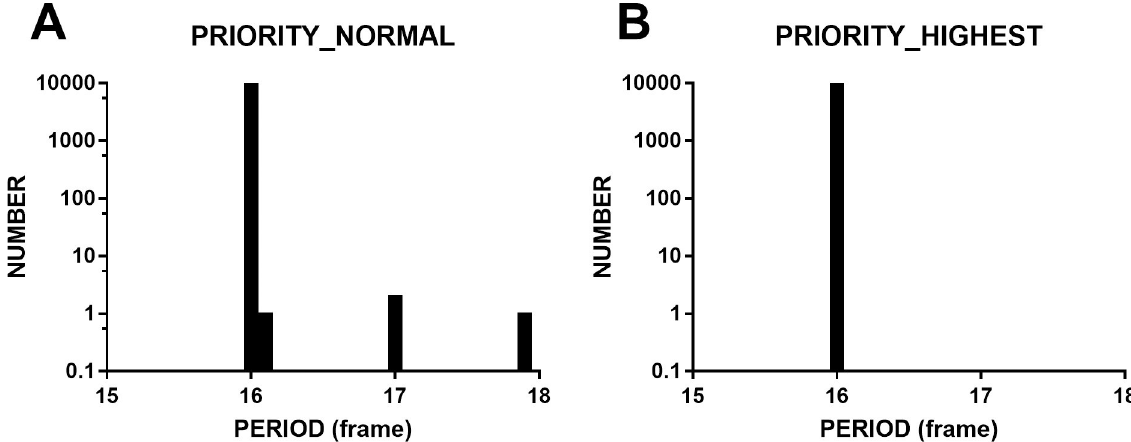
Fig 2. A: shows running at normal priority, and B: shows running at real-time priority. The periods at normal priority were distributed between 15.9 frames and 18.0 frames, and longer periods occurred rarely (mean = 16.0 frames, SD = 0.02 frames, range = 1.9 frames, FLR = 0.04%). The periods at real-time priority were 16.0 frames, and no longer periods occurred (mean = 16.0 frames, SD = 0.001 frames, range = 0.01 frames, FLR = 0%).